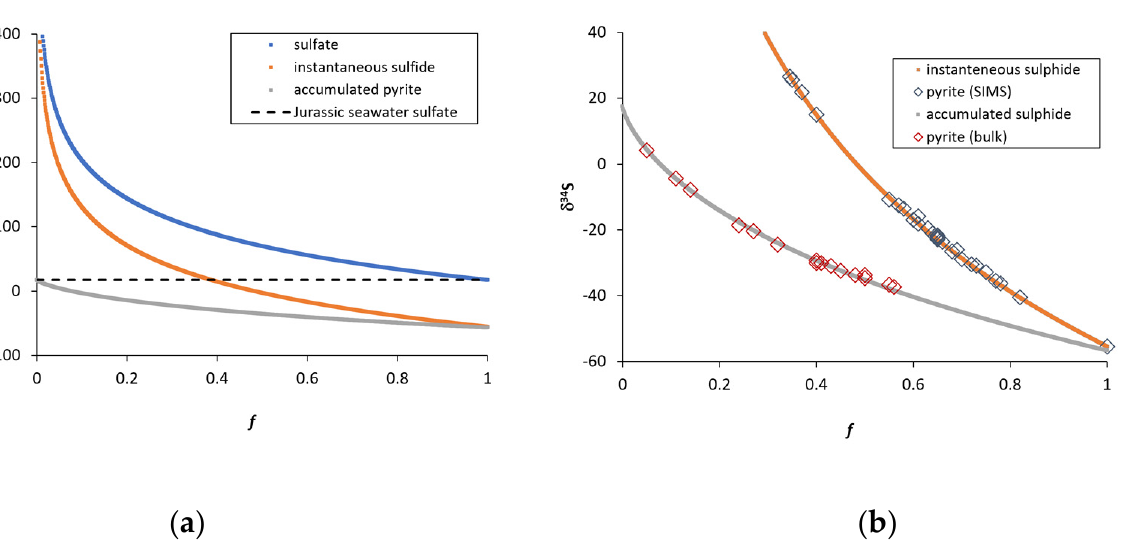
Figure 7. Rayleigh fractionation calculations showing ( a ) Isotope evolution of aqueous sulfate, instantaneous sulfide, and accumulated pyrite with remained fraction of sulfate ( f ). The dashed line is the δ 34 S value of marine sulfate in the late Jurassic (17.5‰); ( b ) The δ 34 S data obtained by IRMS (bulk) and SIMS (in situ) techniques are placed on the accumulated and instantaneous curves by adjusting f values.